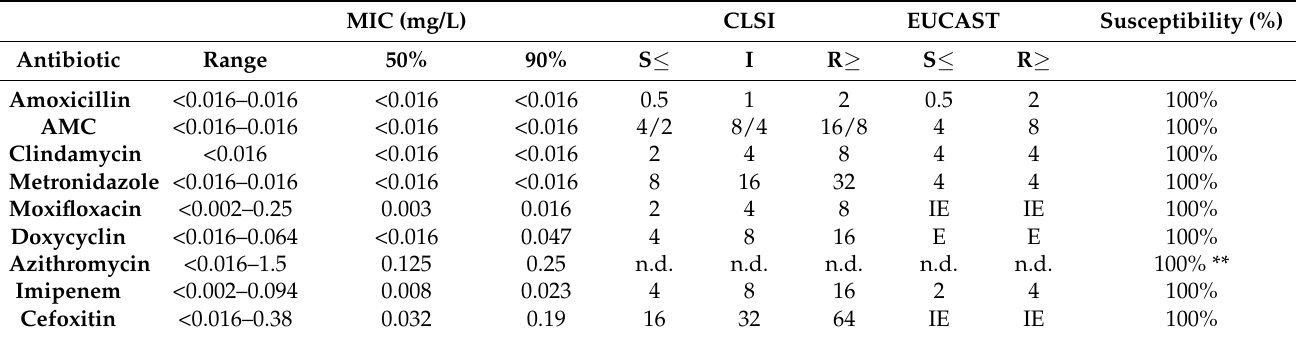
Table 2. MIC range, together with MIC50 and MIC90, of 3 Porphyromonas gulae and 29 P. gingivalis strains subjected to this study. If defined, CLSI and EUCAST breakpoints are also given and the corresponding